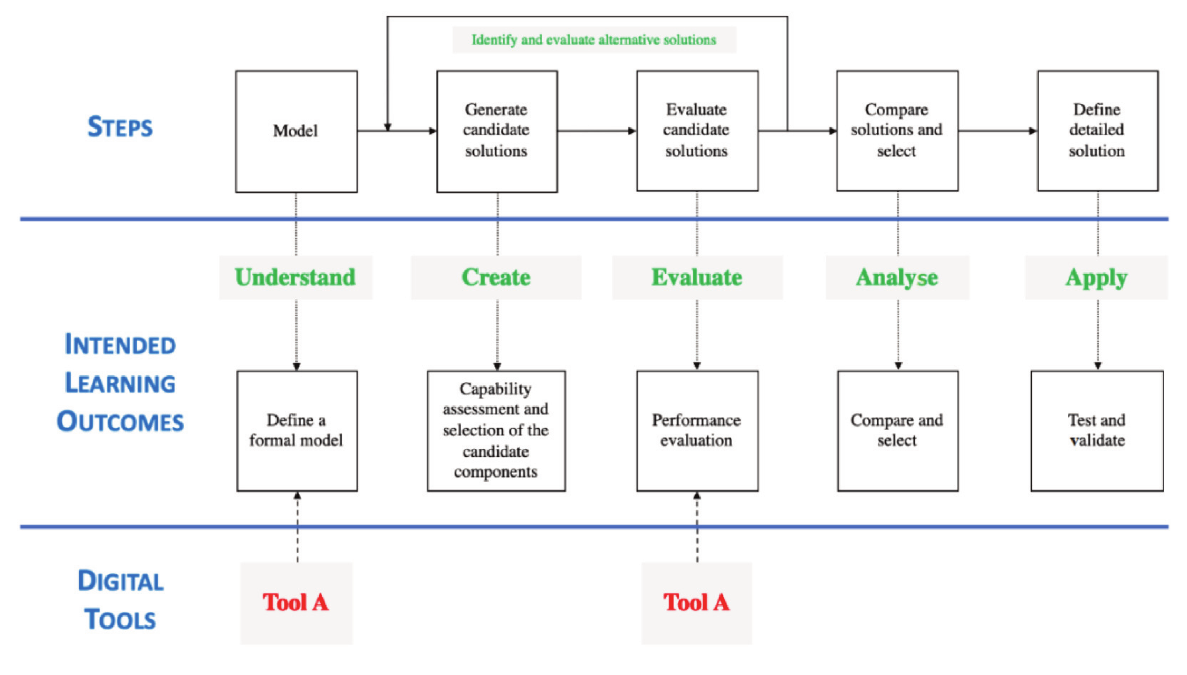
Fig. 2. Structure of a